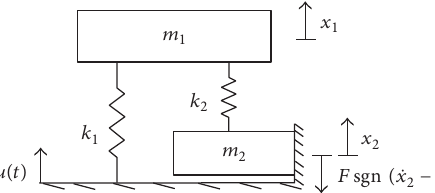
Figure 4: A two-degree-of-freedom system isolation configuration with Coulomb friction subjected to a base